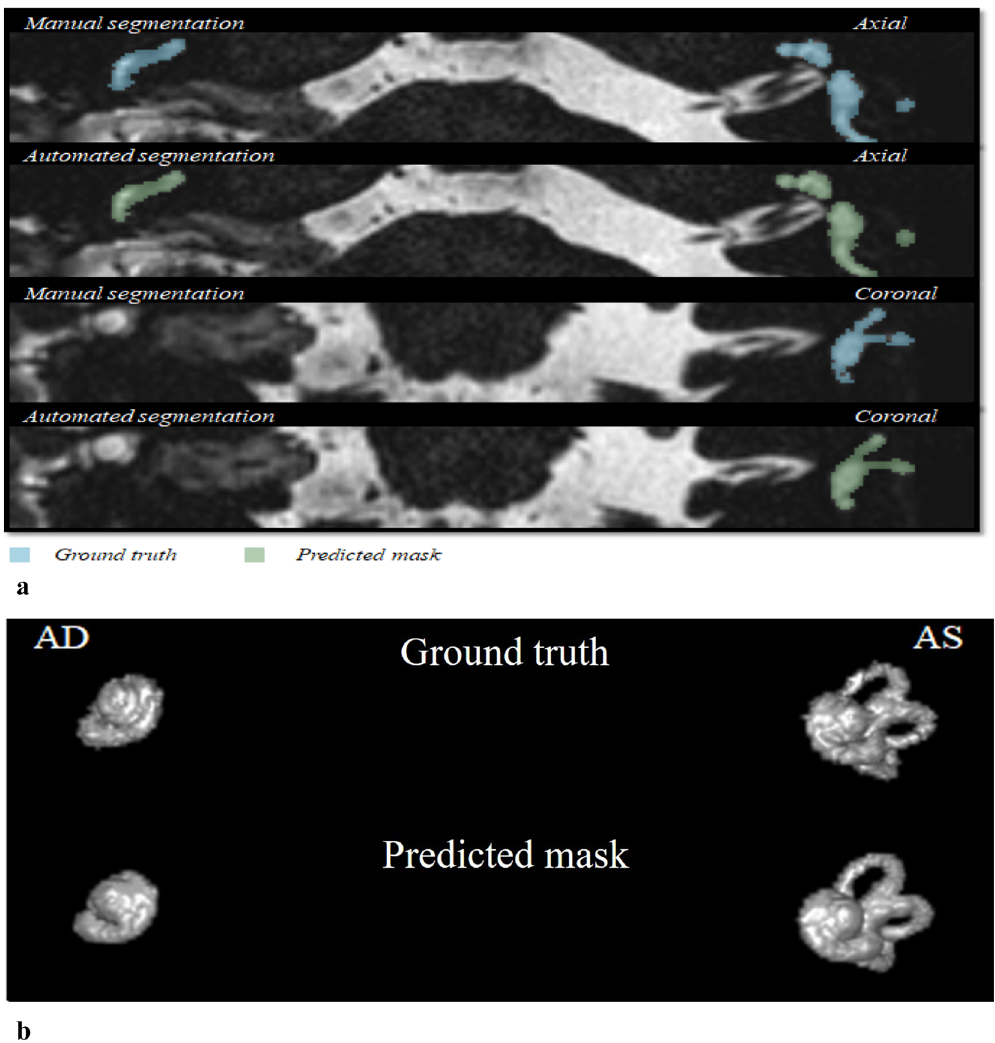
Figure 9. ( a ) Example of one of the clinical validation MRI scans in the axial and coronal plane. This case shows the presence of a vestibular schwannoma after a translabyrinthine resection on the right side. Therefore, the right semi-circular canals and vestibule are not segmented. DSC: 0.8973, ground truth volume: 316.11 mm 3 , true positive volume: 294.69 mm 3 , true positive rate: 93.22%, false negative rate: 6.77%. False discovery rate: 7.3%. ( b ) The 3D volume rendering of the ground truth and the predicted mask. The semi-circular canals and the vestibule of the right inner ear were not displayed on MRI. The model has correctly not segmented the semi- circular canals and the vestibule. AD auriculum dextra, AS auriculum